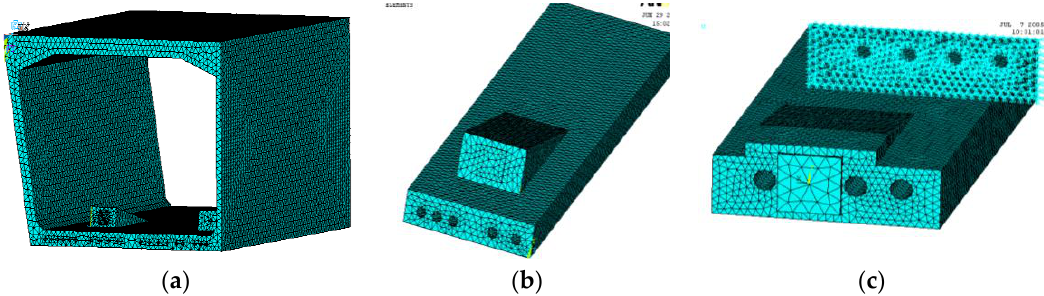
Figure 3. Full-scale specimens: ( a ) top slab; and ( b ) bottom slab.